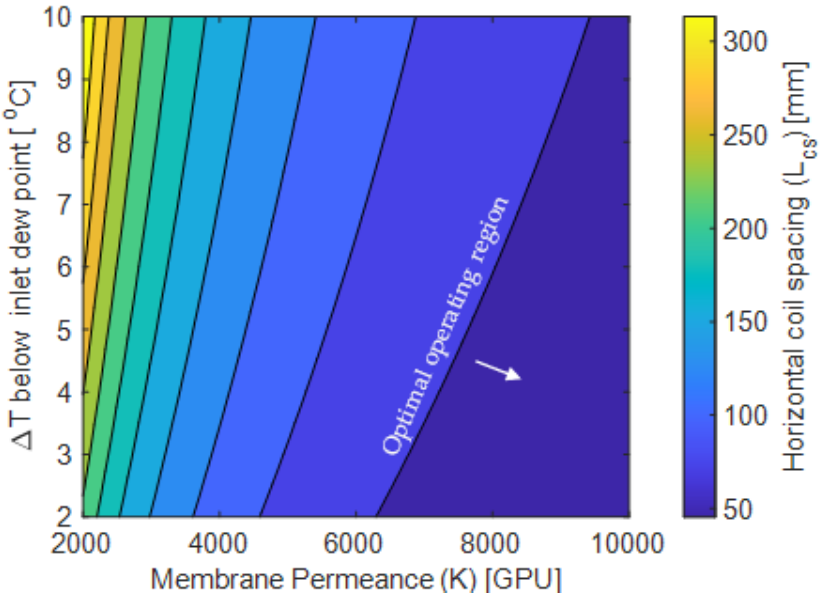
Figure 10. Horizontal coil spacing optimization. T in = 27 ℃ , RH in = 70%, with L × H × W as 0.8 m × 0.006 m × 1m, h cs = 0.006 m, Re = 4000. The number of cooling coils were decided based on horizontal coil spacing and target temperature to be achieved at the channel outlet.